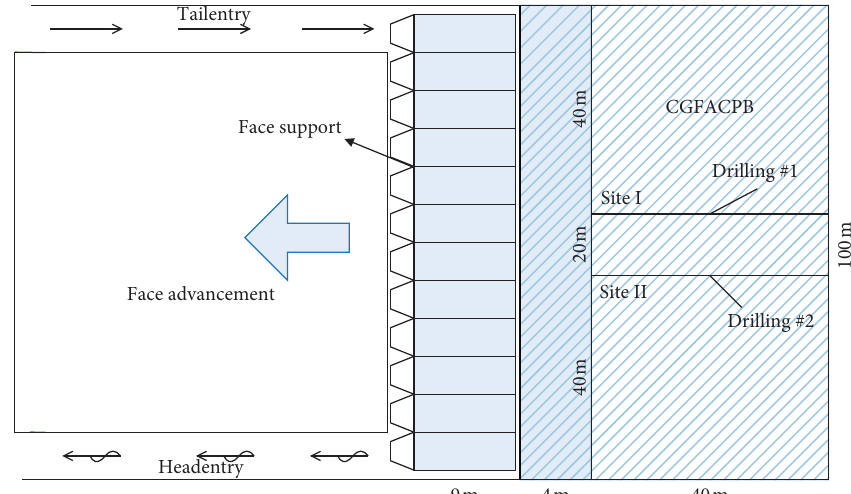
Figure 2: Field coring layout